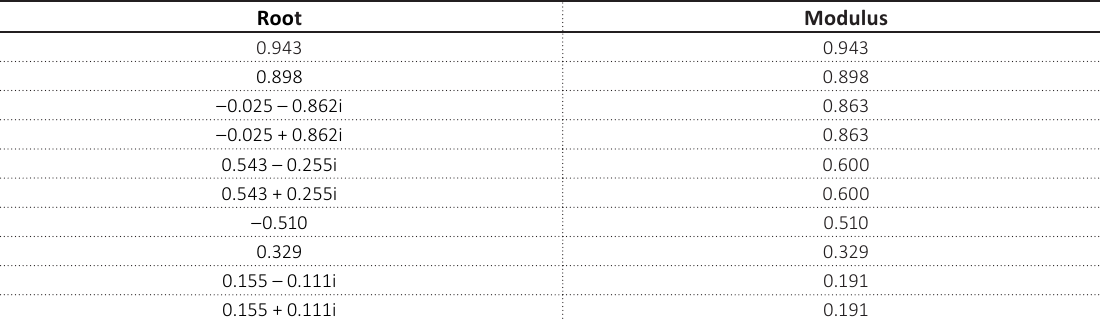
Table A3. Polynomial test result (Islamic)